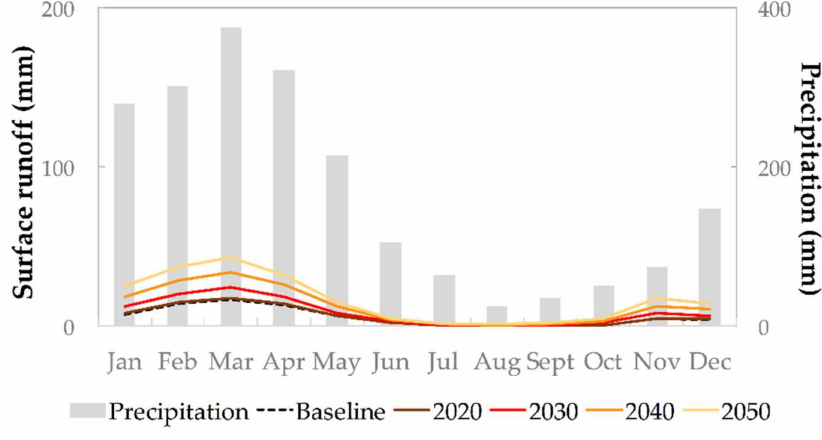
Figure 8. Monthly average simulated surface runoff for 2020, 2030, 2040, 2050, and the baseline.